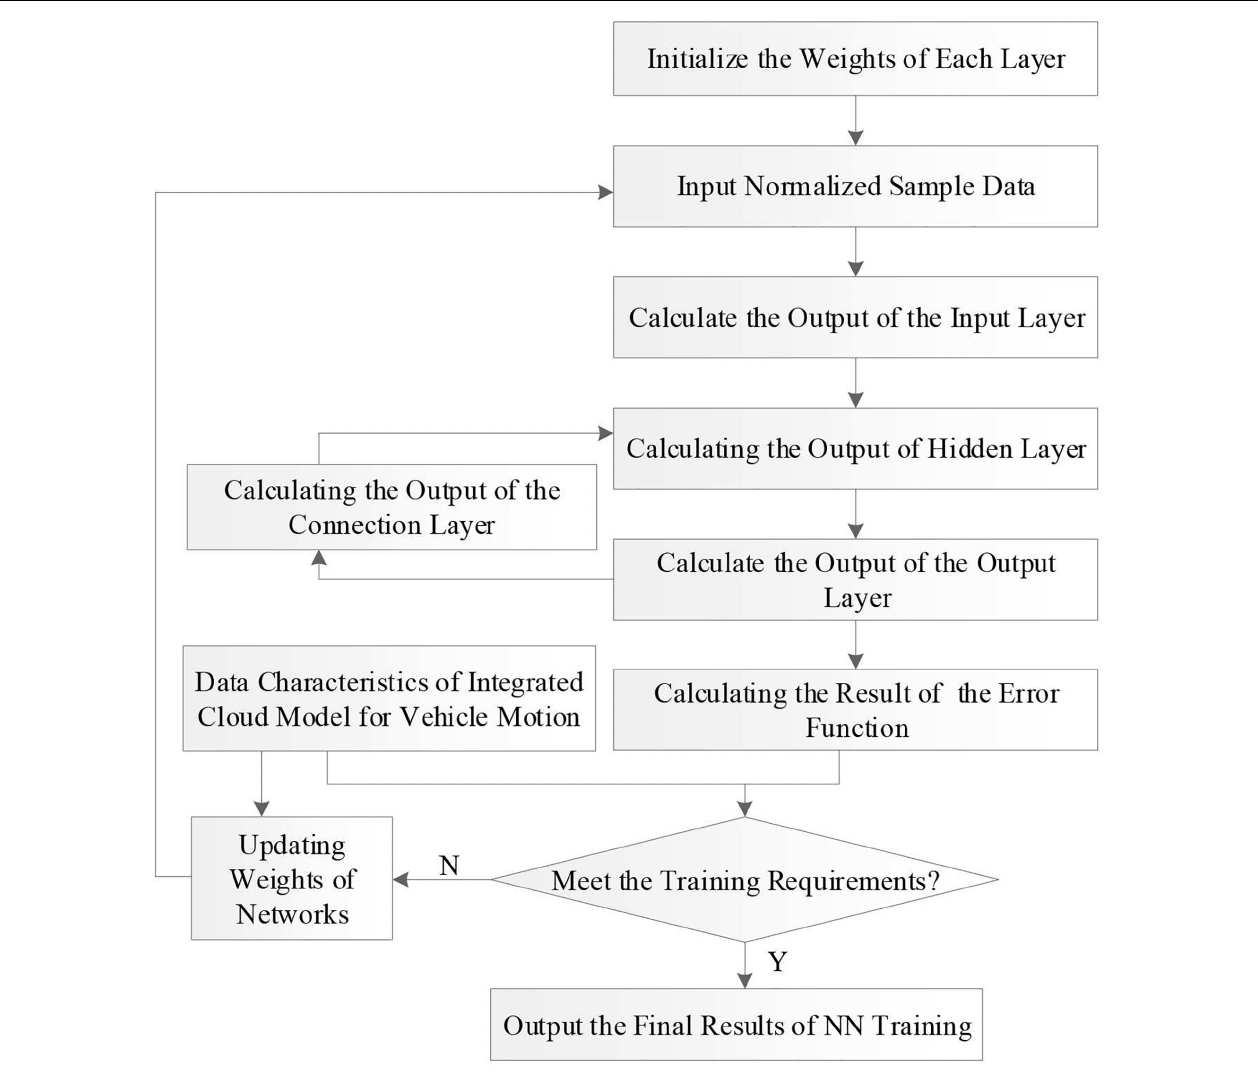
FIGURE 8 | Flow chart of the cloud model and Elman neural network (CM-ENN) learning algorithm.